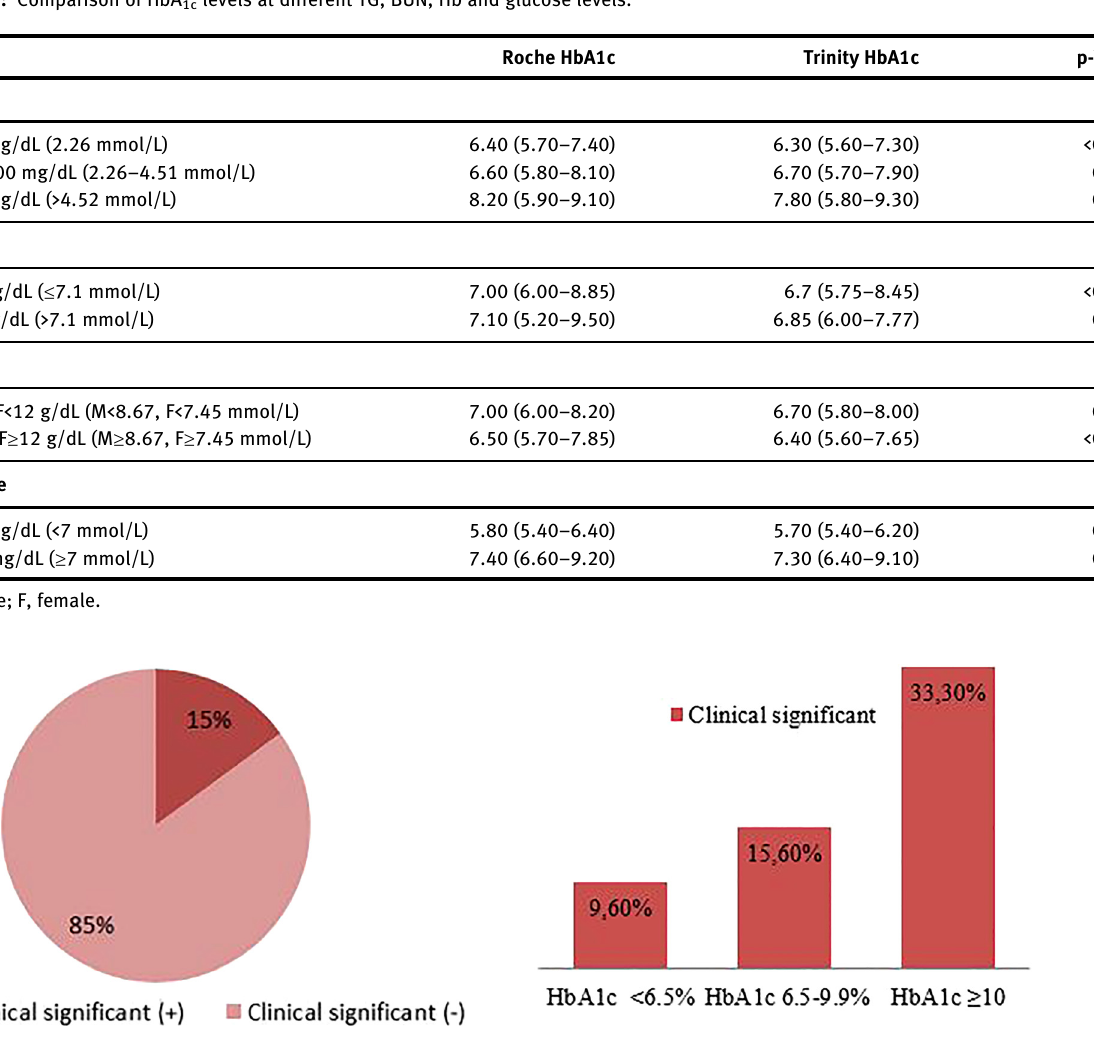
Figure 3: Evaluation of the difference between the two methods in terms of clinical significance.